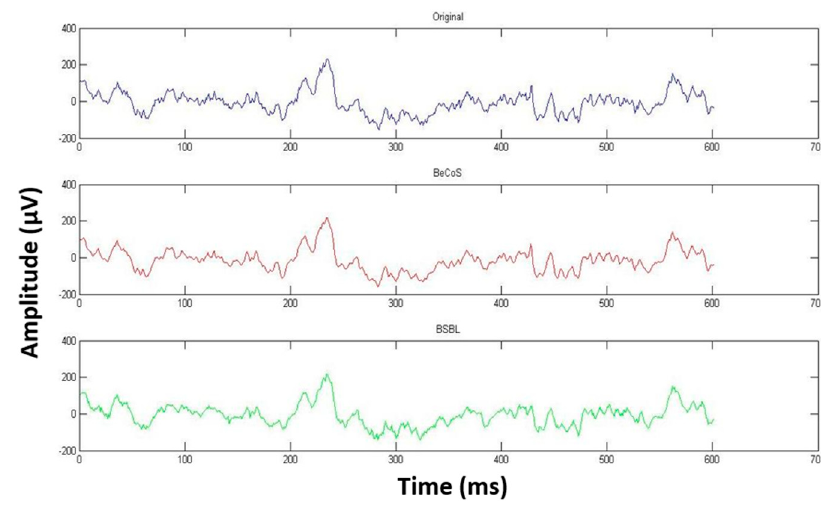
Figure 11. CW-SSIM for Channel 4 [6300:6900].